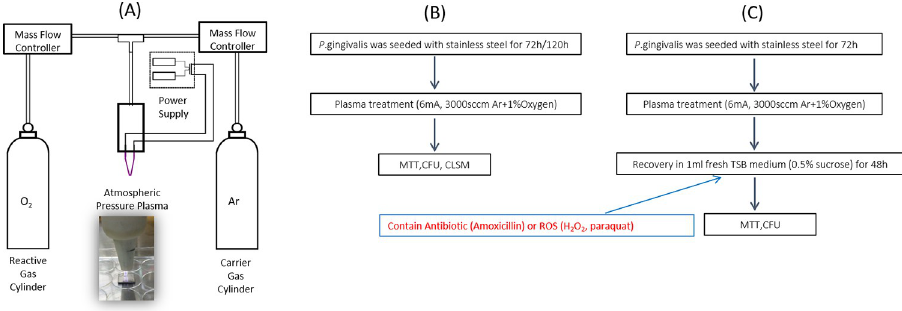
Fig 1. Experiment illustrations. A) sketch of the plasma brush, B) Experimental flow chart of the direct plasma destruction on biofilms, C) Experimental flow chart of the biofilm recovery after plasma